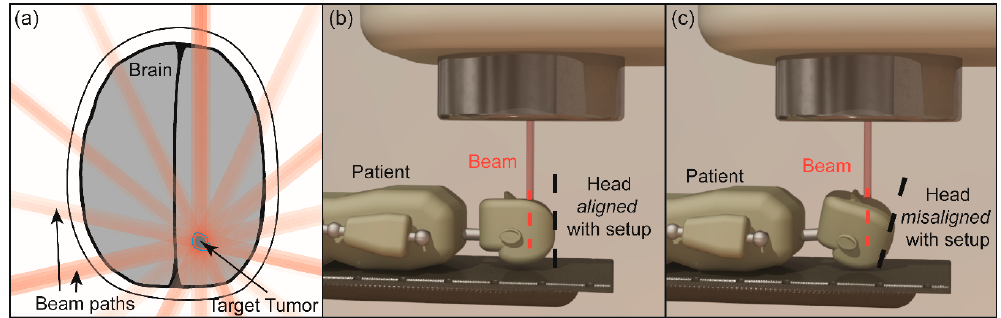
Figure 1. ( a ) Example of conformal radiotherapy for targeting a brain tumor; ( b , c ) Schematic illustrations for a patient receiving external beam radiation therapy for brain cancer. Initially, the beam is delivered to the right target with a good alignment ( b ), but the motion causes the head misalignment ( c ), which makes an error relative to the planned delivery. The most notable sources of uncertainty are improper alignment of a patient with the prescribed field. An example in Figure 1b,c shows intrafraction motion, caused by patient movement during the treatment. Setup errors have been minimized by employment of immobilization equipment and